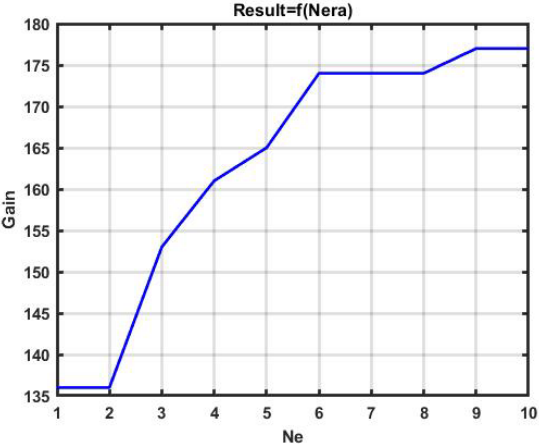
Figure 9. Effectiveness of the CSF strategy with evolutionary optimization.